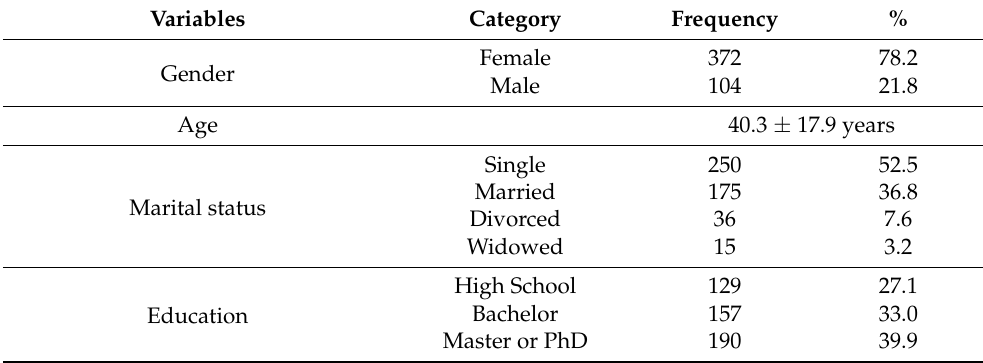
Table 1. Summary of the characteristics of the population included in this